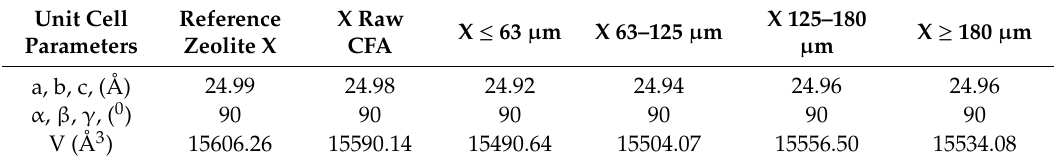
Table 3. Unit cell parameters of obtained zeolites in comparison to the reference zeolite sample.